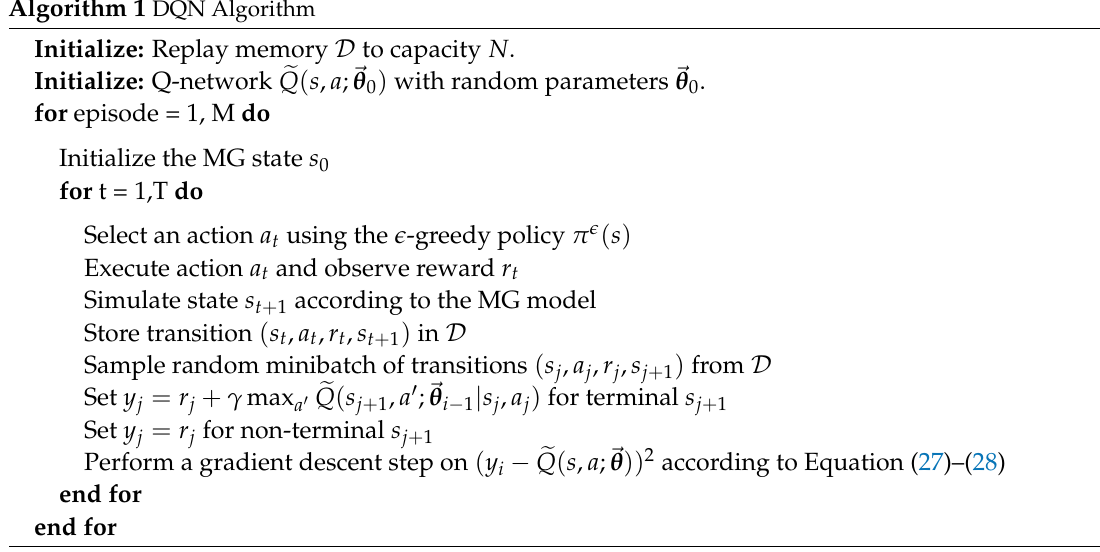
Algorithm 1 DQN